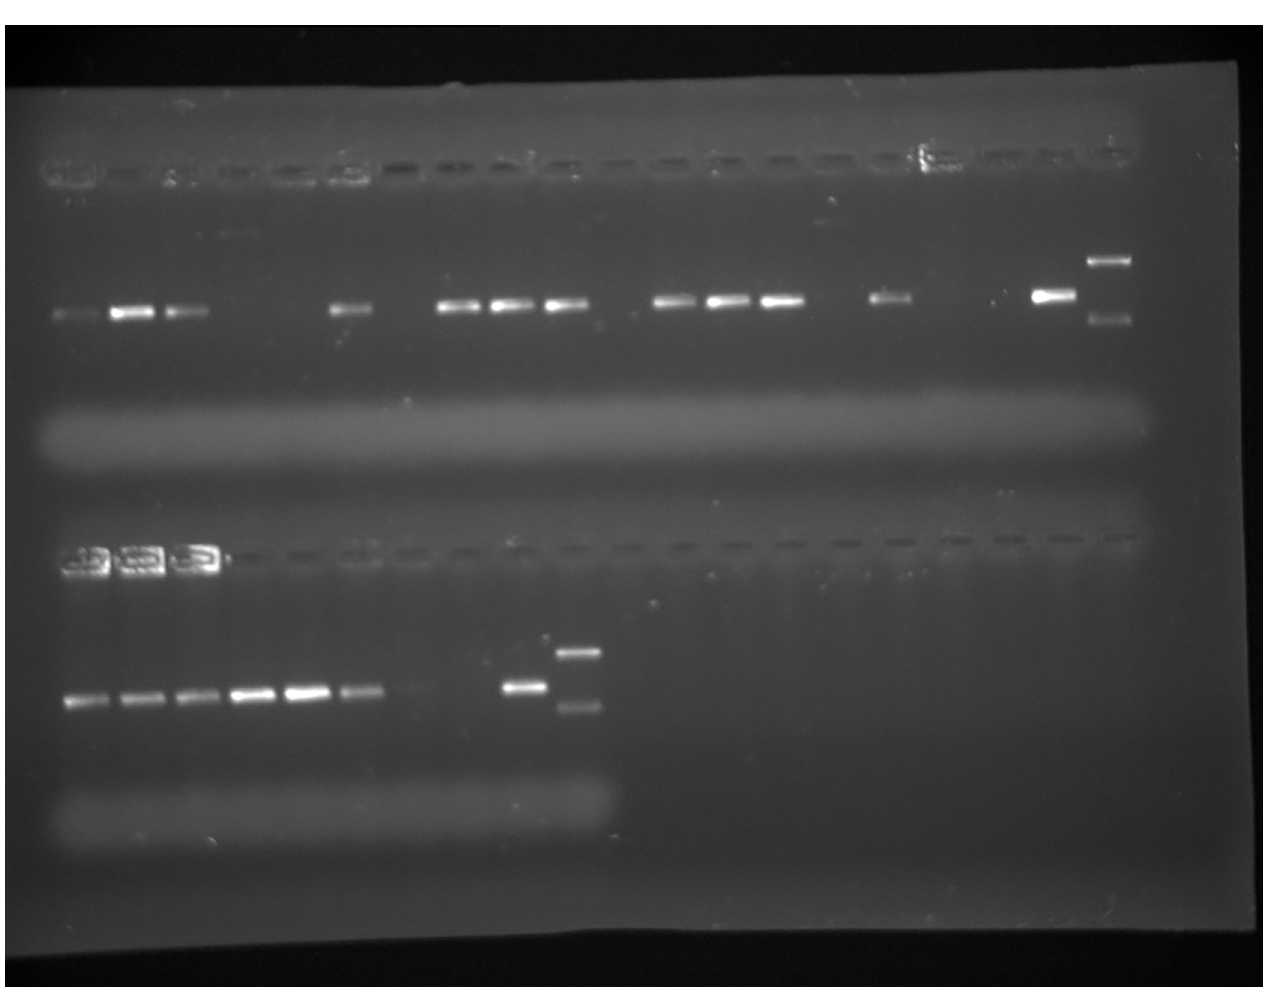
Fig 7. The separation of a PCR product for P . gingivalis for subgingival plaque samples.